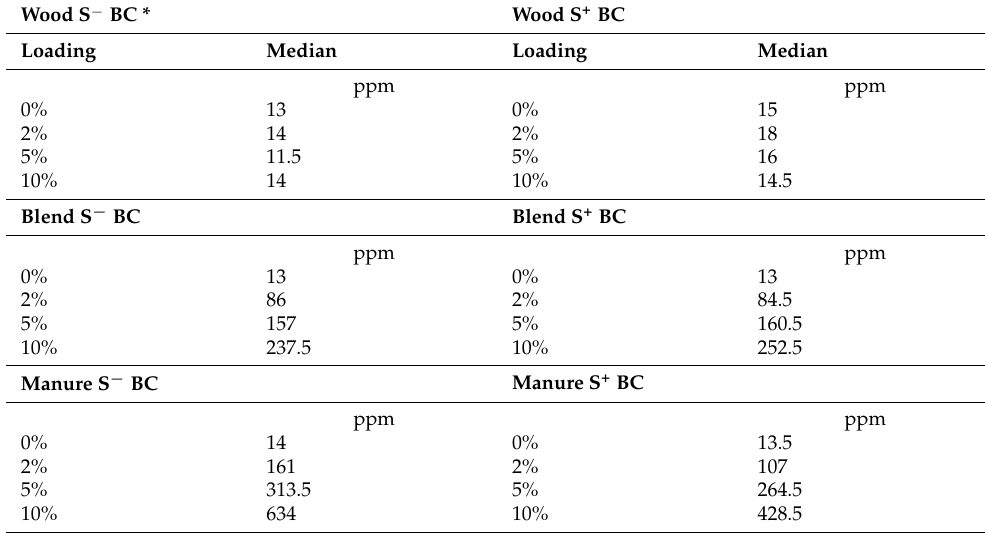
Table 12. Soil phosphorus ppm median values for Lolium multiflorum